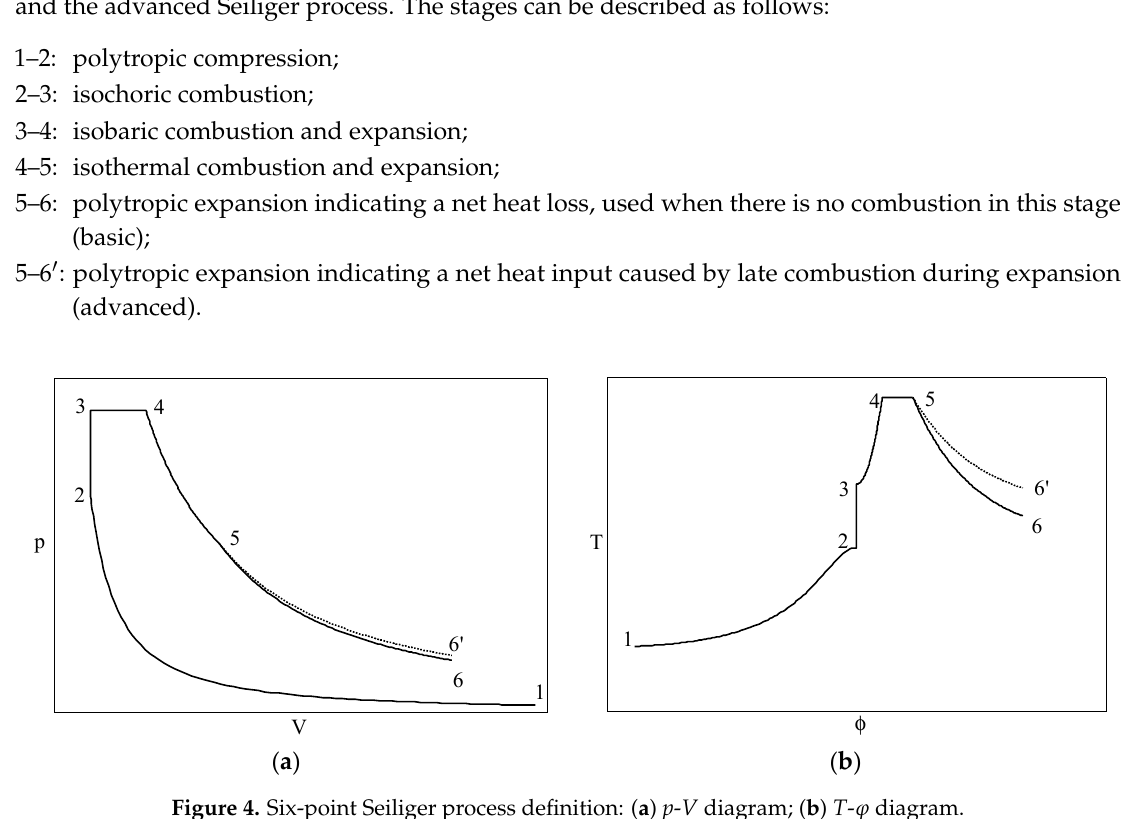
Figure 3. Map of measured points.